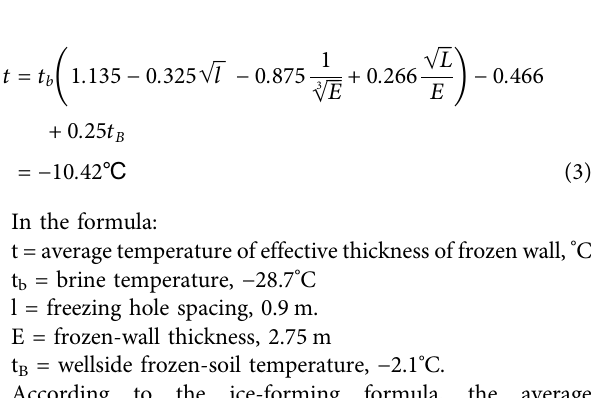
FIGURE 13 | Measured hole